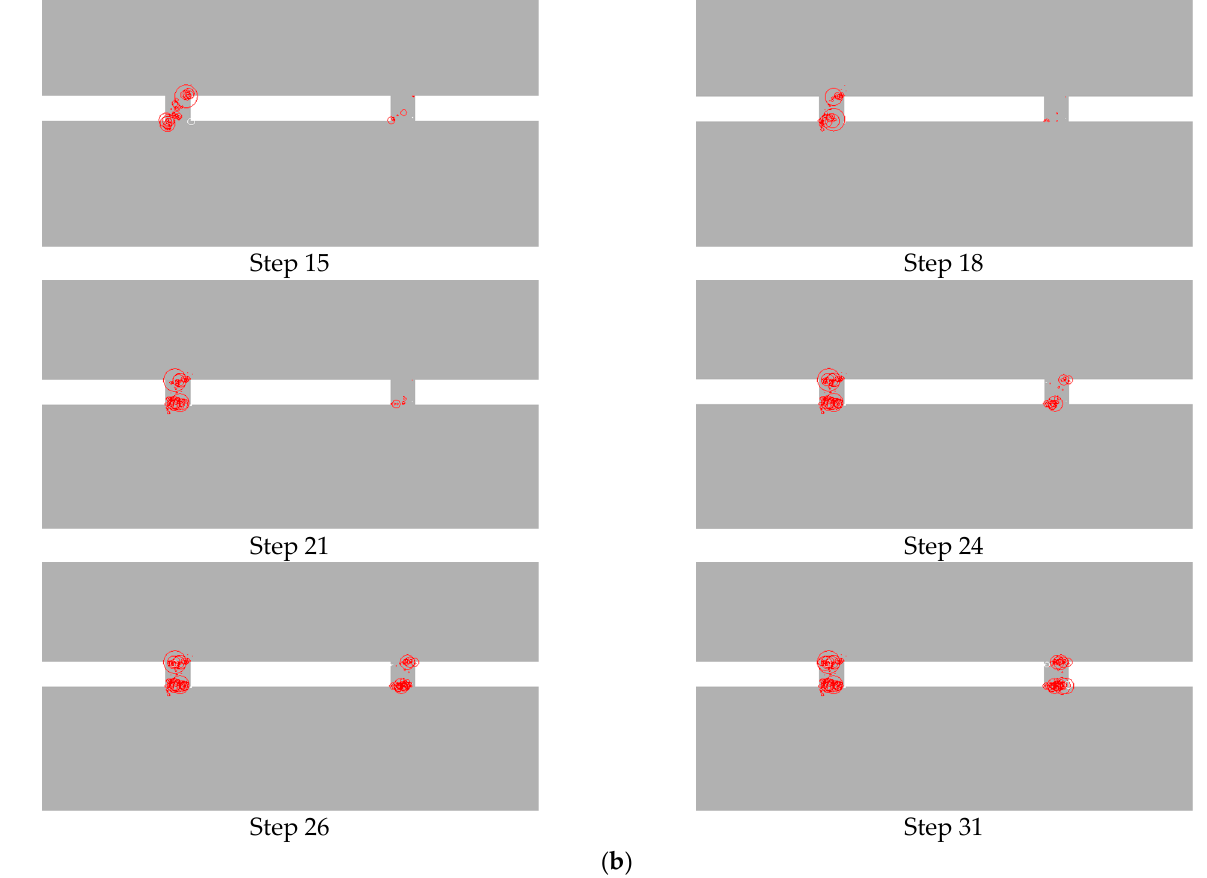
Figure 3. Failure of model with two locked patches of same strength: ( a ) shear stress distributions, ( b ) AE distributions.